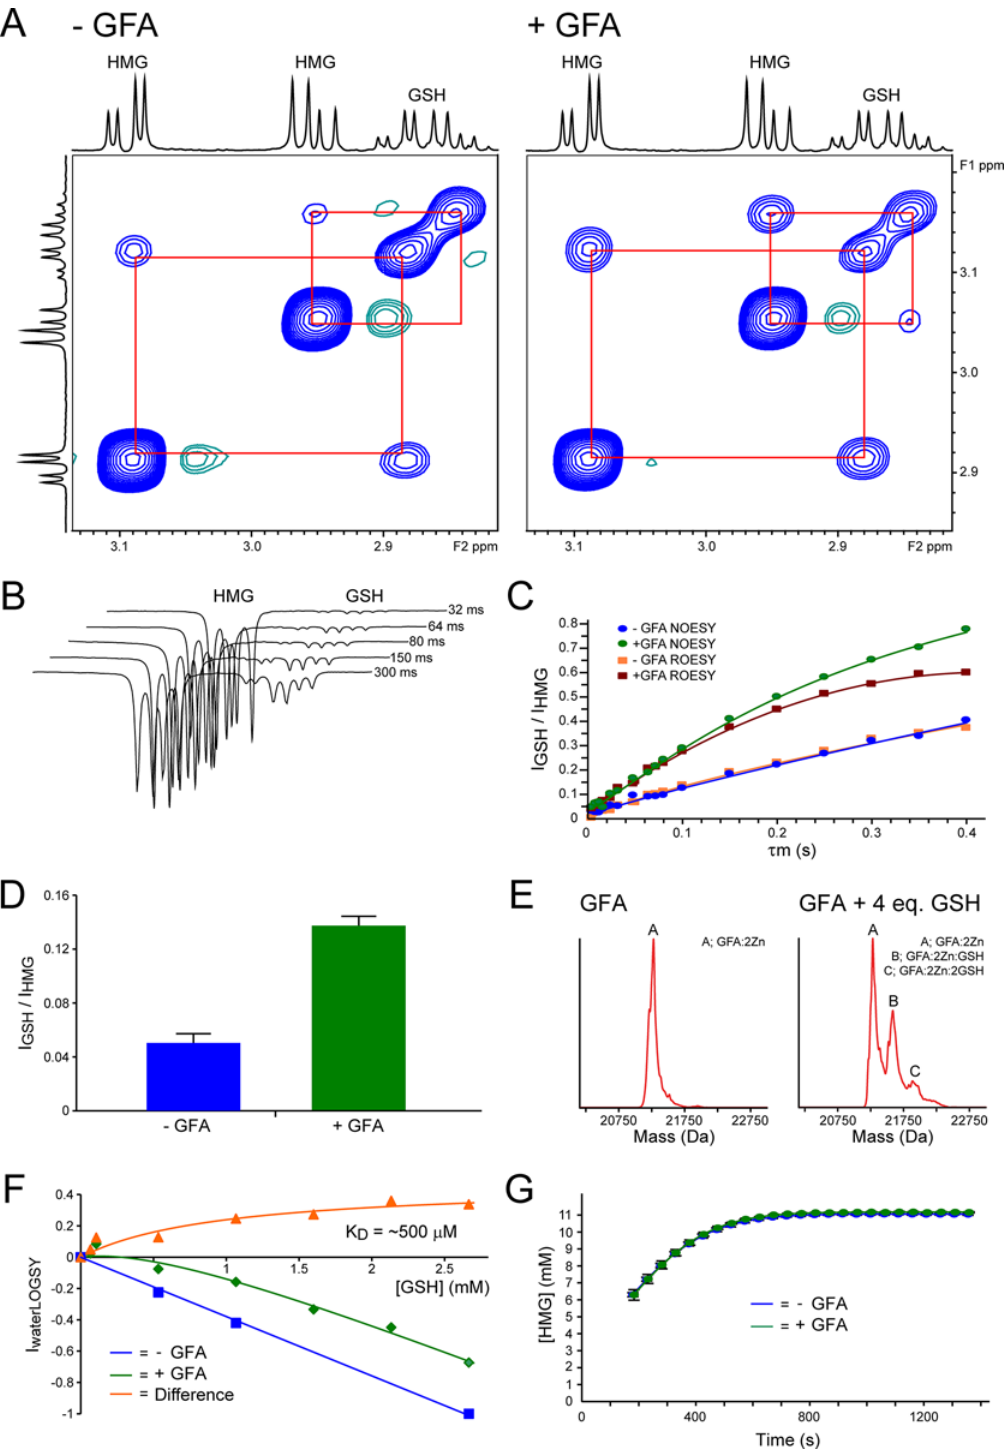
Fig 2. GFA is a GSH-binding protein that induces an increase in EXSY correlation intensities between GSH and HMG, but does not catalyse HMG formation / fragmentation. (A) 2D EXSY spectra of equilibrium mixtures of GSH (initial concentration 15 mM) and HMG in the absence (left) and presence (right) of GFA (20 μ M). Mixing time ( τ m ) = 400 ms. EXSY-correlation intensities between GSH and HMG are increased in the presence of GFA. (B) 1D EXSY spectra of equilibrium mixtures of GSH (initial concentration 15 mM) and HMG in the presence of GFA (20 μ M) conducted at different mixing times ( τ m = 32 – 300 ms). Irradiation (inversion) of a β -cysteinyl resonance of HMG ( δ H 2.95 ppm) induced an exchange correlation at δ H 2.87 ppm, corresponding to the β